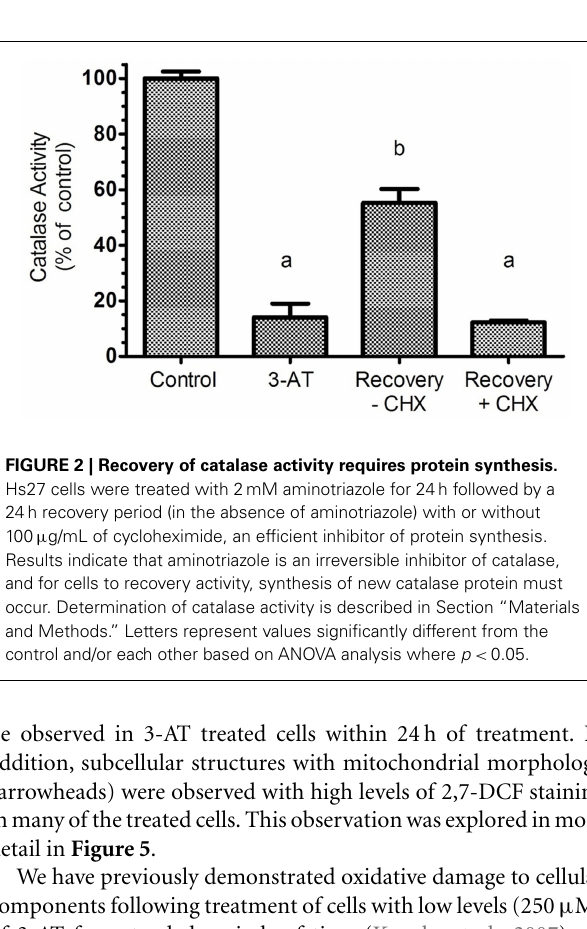
INHIBITION OF PEROXISOMAL CATALASE RESULTS IN